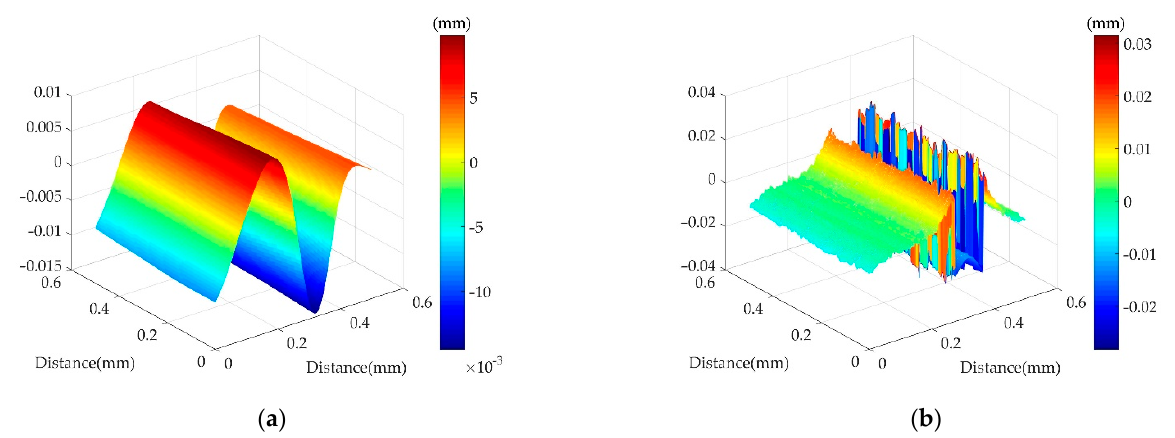
Figure 14. ( a ) Waviness surface and ( b ) roughness surface after using the approximating spline filter.